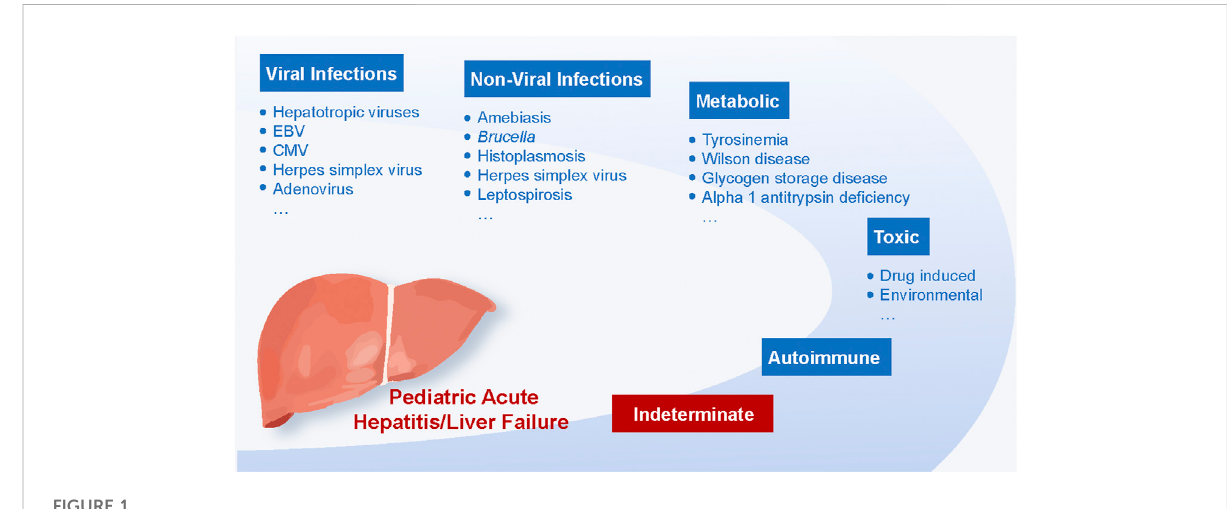
FIGURE 1 Determinate pediatric acute hepatitis and liver